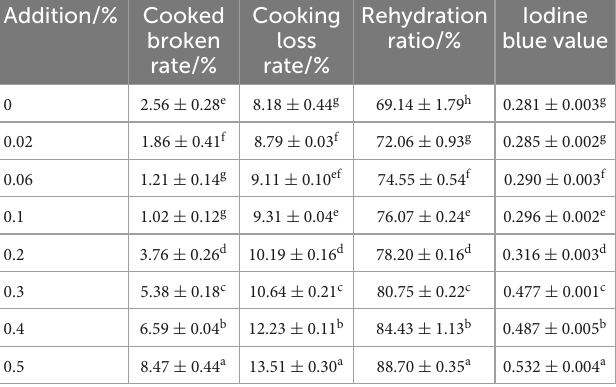
TABLE 7 Effect of sodium bicarbonate on the color changes of semi-dried rice noodles. Addition/%